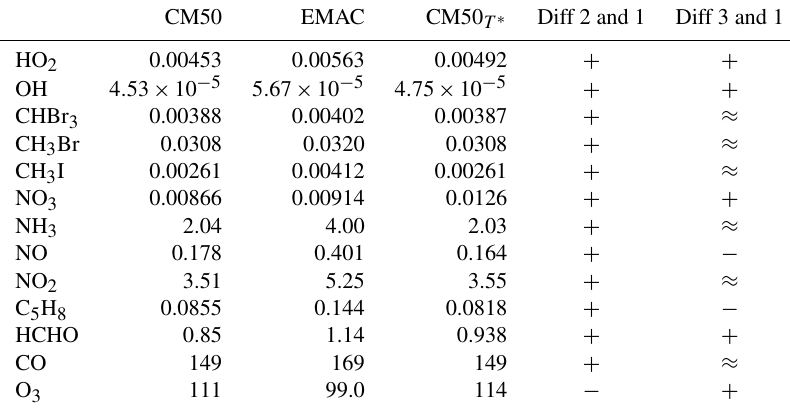
Table 8. Area-averaged ground-level concentrations (for a box from 5 ◦ W–20 ◦ E, 20–55 ◦ N) in µgm − 3 of various chemical species. The second through fourth columns display the values for CM50 , EMAC and CM50 with changed temperature for the submodel MECCA (CM50 T ∗ ), respectively. The fifth column indicates if the differences between EMAC and CM50 are positive ( + ), negative ( − ) or if there is only a minor difference ( ≈ ). The last column indicates the corresponding differences between CM50 and CM50 with changed temperature field for